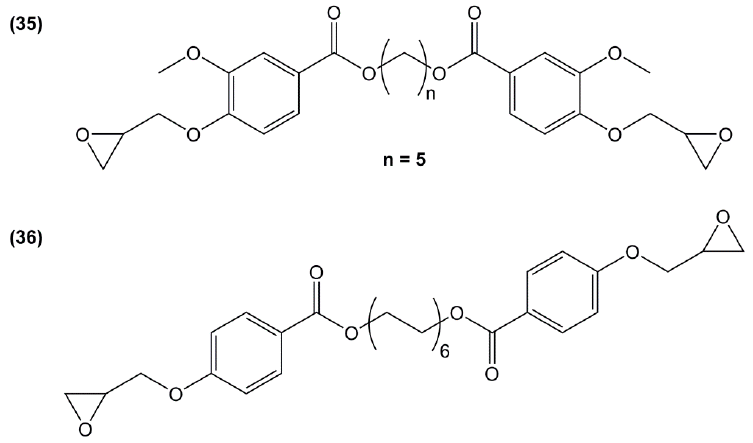
Figure 23. Di-epoxy monomers with longer ester spacers between the aromatic rings.